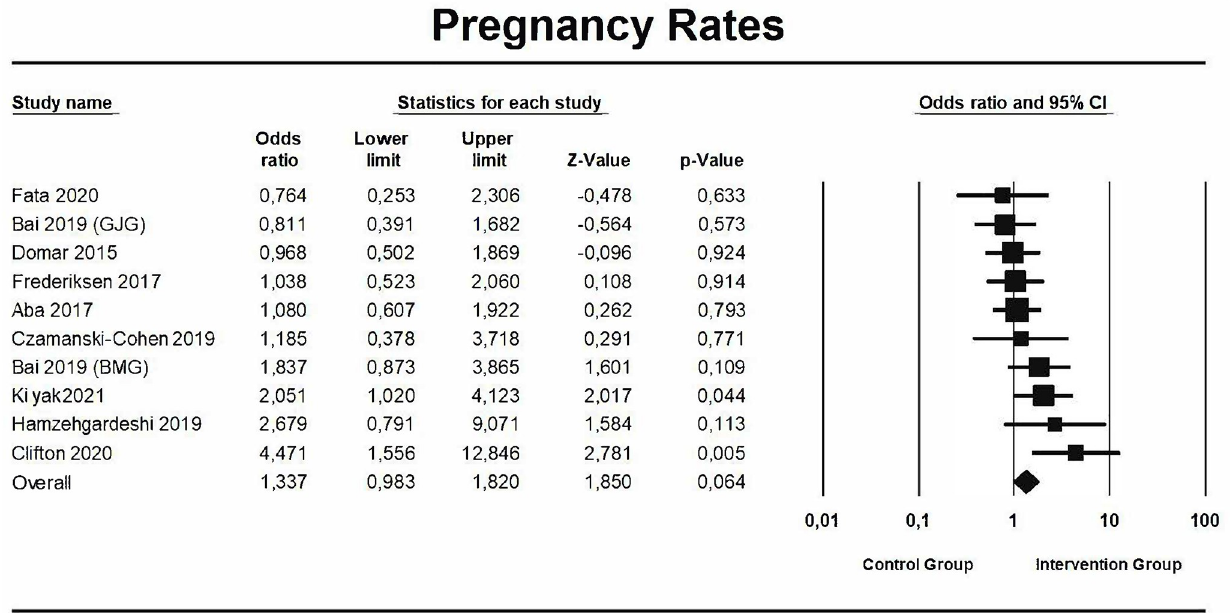
Fig 4. Results for pregnancy rates. Hedges´s g, confidence interval (CI), Z-Value, p-Value and forest plot for pregnancy rates (created with CMA Software [39]).